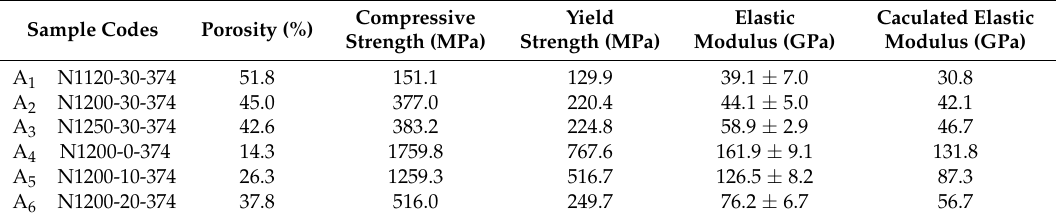
Figure 8. Selected load-displacement curves of the porous HNASSs with different amounts of space holder (0 wt. %, 10 wt. %, 20 wt. % and 30 wt. %) sintered at 1200 ◦ C for 2 h ( a ); Experimental and calculated elastic modulus ( b ). Table 2. Summarized mechanical and physical properties of porous